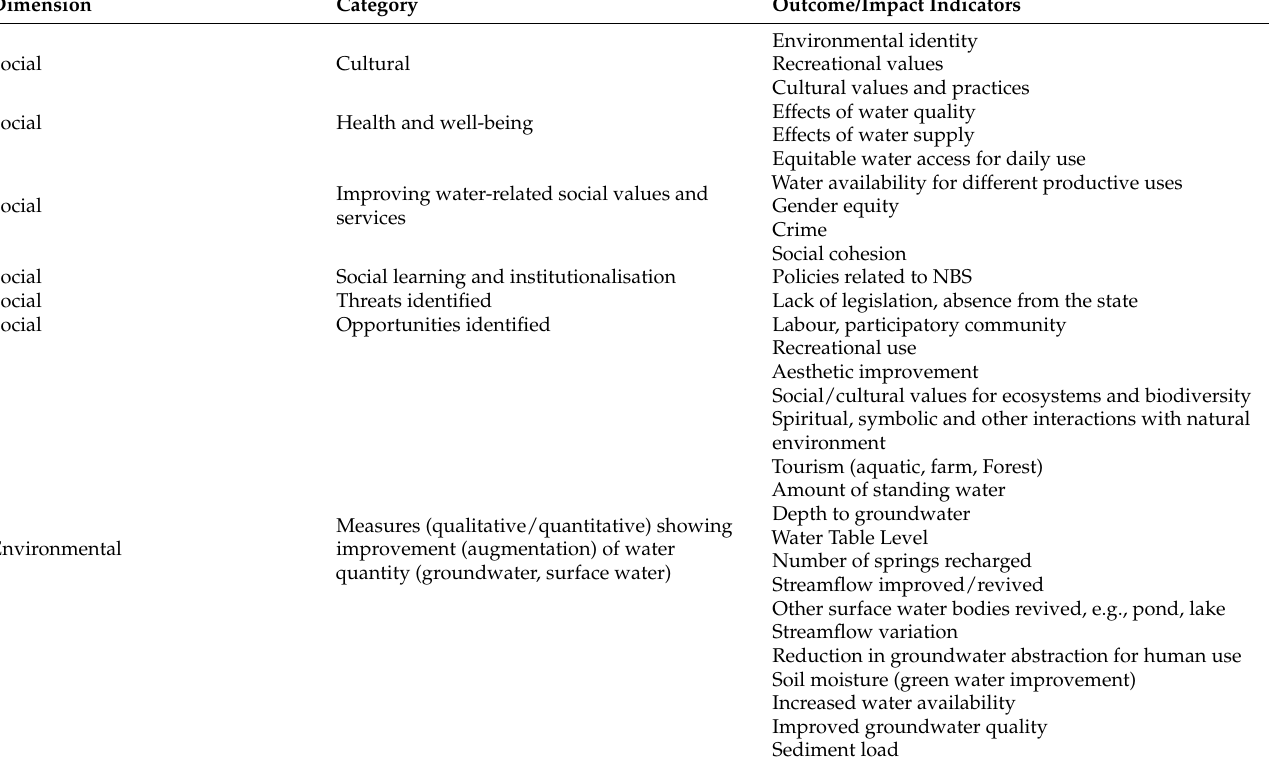
Table 2. Results indicators developed for the framework proposed by de Lima et al.,